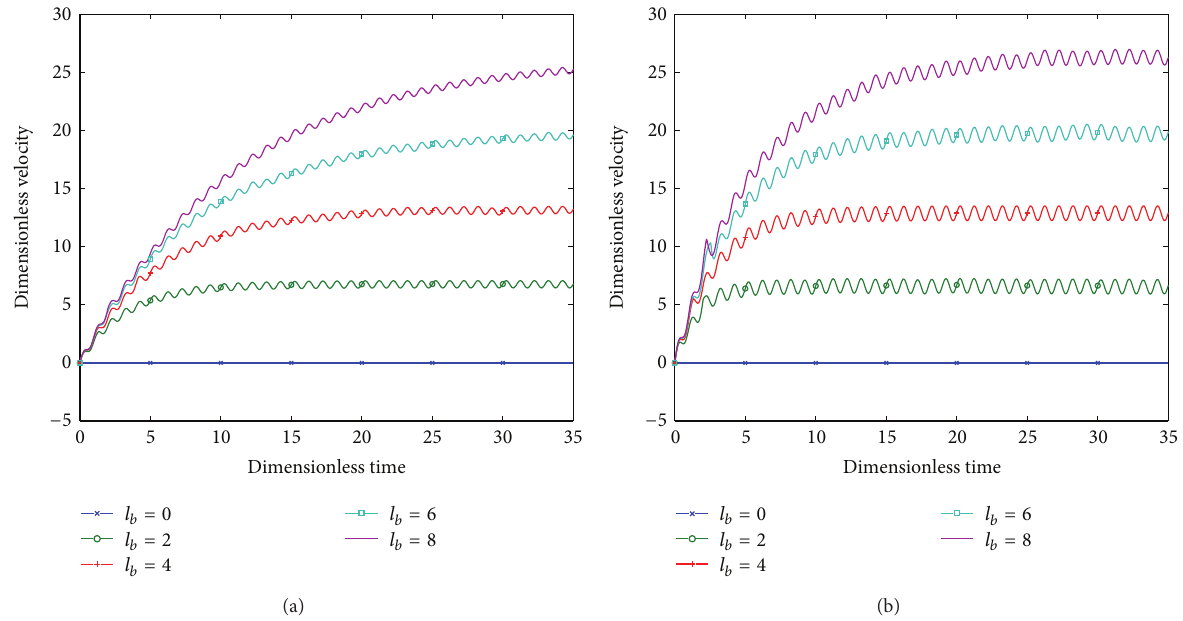
Figure 8: Diagrams showing the convergence of numerical results of the fluid velocity on the wall to the steady state pulsatile velocity field under various slip parameters 𝑙 𝑏 for two different artery radii: (a) 𝑟 = 0.15 cm; (b) 𝑟 = 0.50